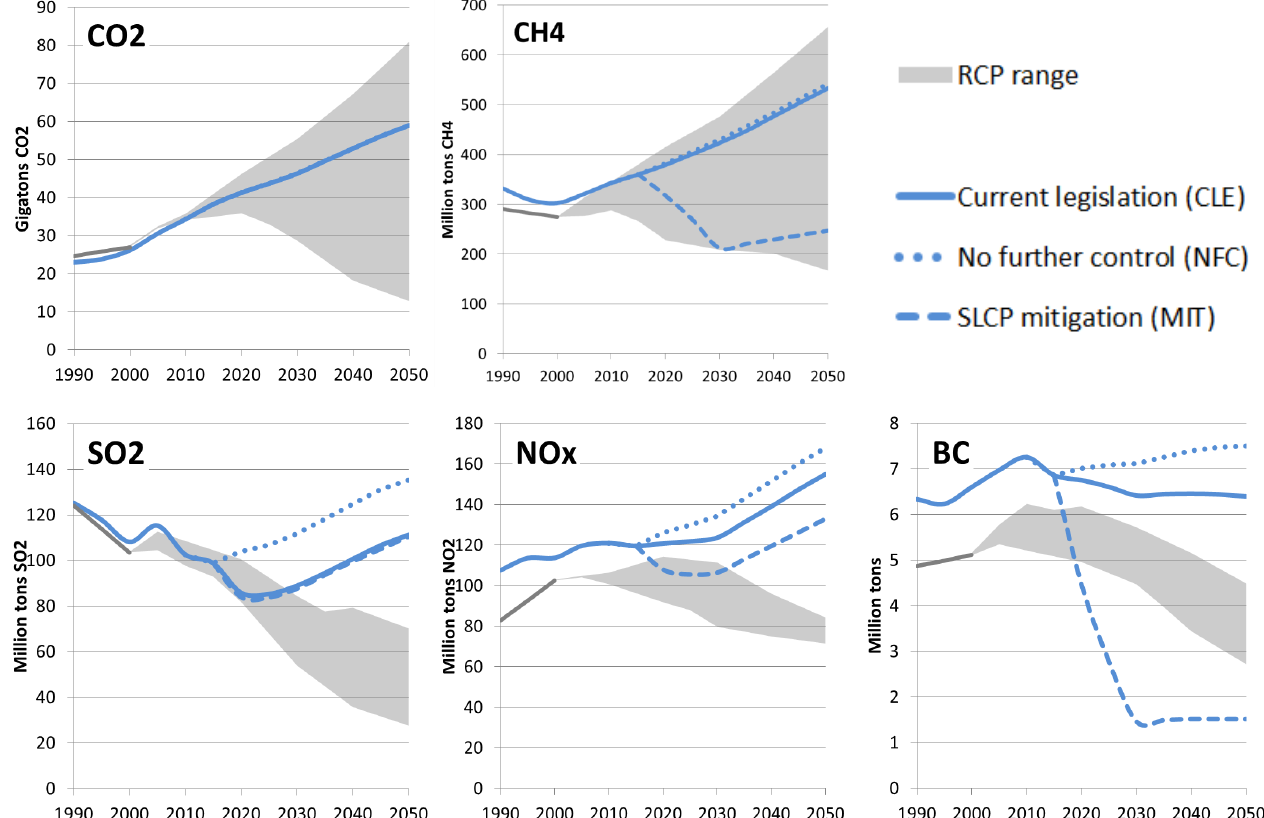
Figure 2. Global annual anthropogenic emissions of CO 2 , CH 4 and key air pollutants (SO 2 , NO x and BC) for the current legislation (CLE), no further controls (NFC) and ECLIPSE SLCP mitigation scenario. Units are Gt for CO 2 and Mt for the SLCPs. Also shown for comparison is the range of the RCP emission scenarios (grey